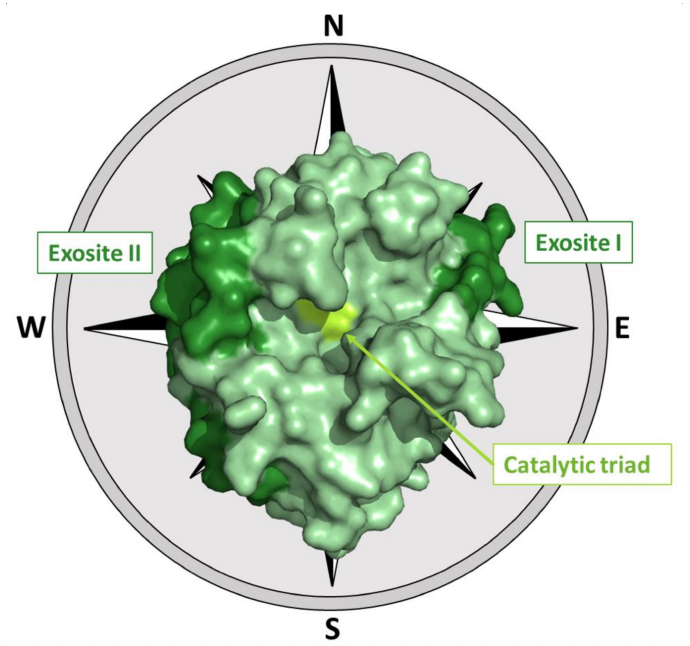
Figure 3. The three-dimensional structure of thrombin (PDB entry 1ppb). The relative locations of the active site and of the two exosites (Table S1) have been also shown using the cardinal points notation frequently adopted for thrombin